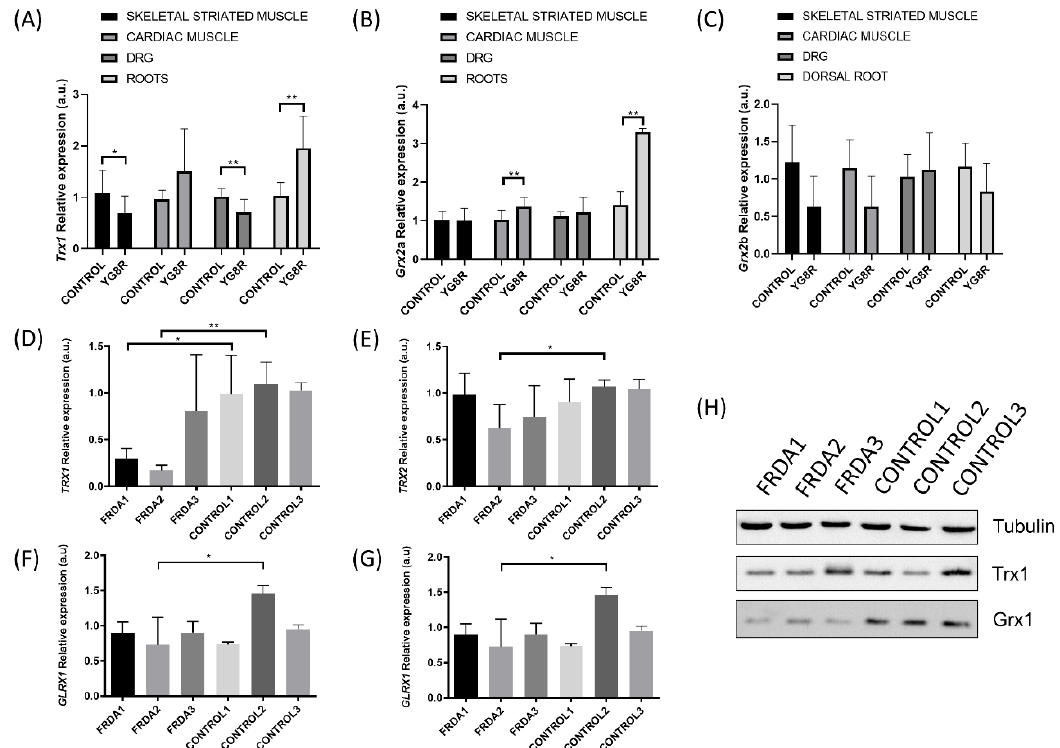
Figure 2. Changes in the levels of Trx and Glrxs expression in mice and human fibroblast Friedreich’s ataxia (FRDA) models. The relative mRNA expression of Trx1 ( A ), Glrx2 isoform a ( B ), and Glrx2 isoform b ( C ) was determined in skeletal striated muscle, cardiac muscle, dorsal root ganglia (DRG), and nerve roots of a C56B6LJ control mouse ( n = 3) and YG8R frataxin-deficient mouse model ( n = 3). The relative mRNA expression of TRX1 ( D ), TRX2 ( E ), GLRX1 ( F ) and GLRX2 ( G ) was analyzed in fibroblasts from FRDA patients ( n = 3) and healthy subjects ( n = 3). The relative mRNA expression levels were calculated using Glyceraldehyde-3-Phosphate Dehydrogenase (GAPDH) as an endogenous control. ( H ) Western blot analysis of protein levels for TRX1 and GLRX1 in fibroblasts from FRDA patients and healthy subjects. Statistical significance refers to the values for the CONTROL samples for each tissue (* p < 0.05, ** p < 0.01). Methodology is described in Supplementary Materials.